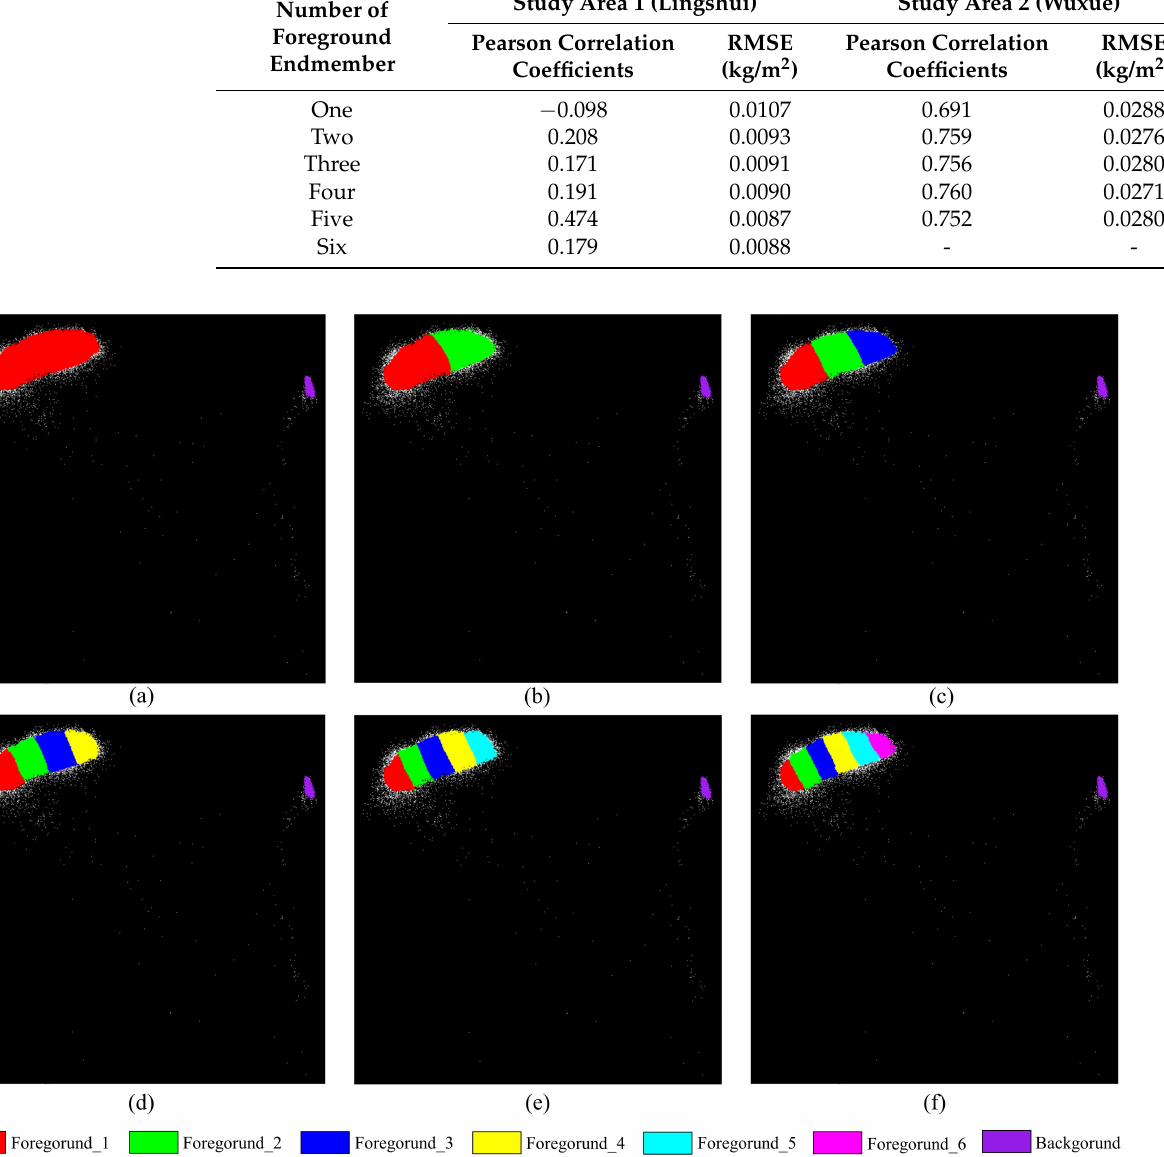
Figure 7. The sketch images of the six kinds of delineating sample strategies in the n-Dimensional Visualizer. ( a ) One fore- ground and one background; ( b ) two foregrounds and one background; ( c ) three foregrounds and one background; ( d ) four foregrounds and one background; ( e ) five foregrounds and one background; and ( f ) six foregrounds and one